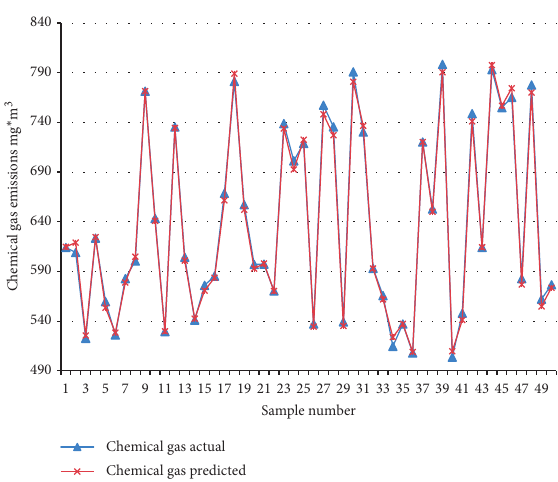
Figure 3: Comparison of chemical gas emission forecast with actual